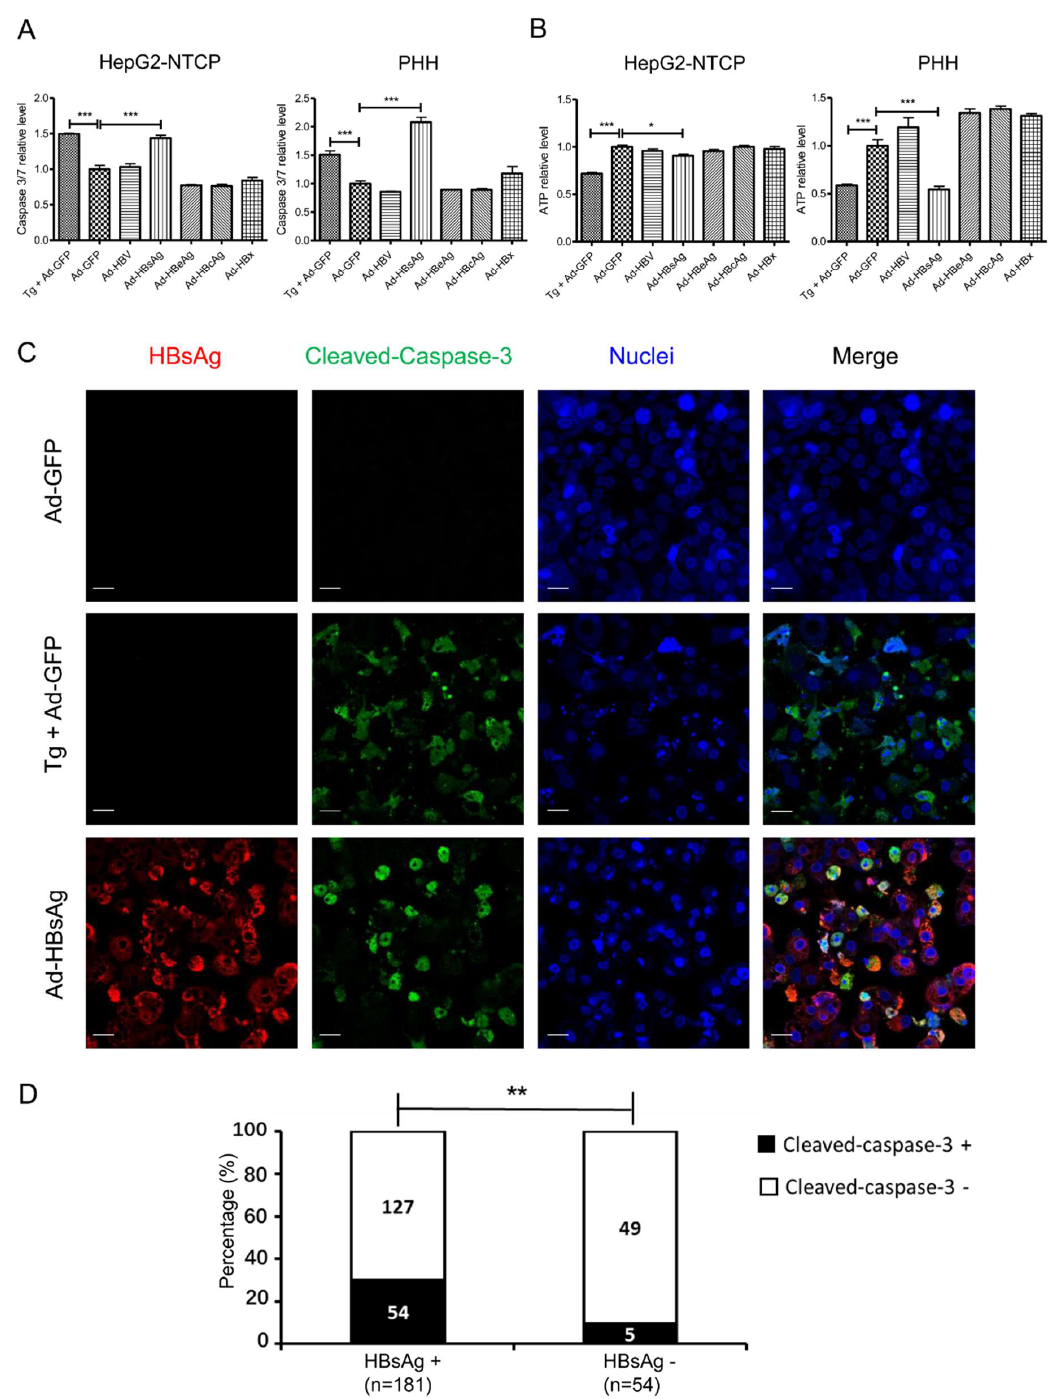
Figure 4. Induction of apoptosis by HBsAg overexpression. HepG2-NTCP cells and PHHs were transduced by AdVs with an MOI of 1 or treated with Thapsigargin (Tg, 1 µ M for 24 h) as a positive control. ( A ) Five days after transduction, apoptosis was evaluated by the Caspase-3 / 7 activity assay. ( B ) Cell viability was measured by ATPlite. The Student’s unpaired two-tailed t test was applied for data analysis. * p < 0.05, *** p < 0.001. ( C ) In AdVs-transduced HepG2-NTCP cells, immunofluorescent staining for HBsAg (red) or cleaved-caspase-3 (green) was performed. Nuclei were stained with Hoechst 33342. Scale bar: 20 µ m. ( D ) Ad-HBsAg transduced cells were grouped by HBsAg staining and measured for cleaved-caspase-3 signals. The ratio of cleaved-caspase-3 positive vs. negative cells was determined and shown. ** represents p <